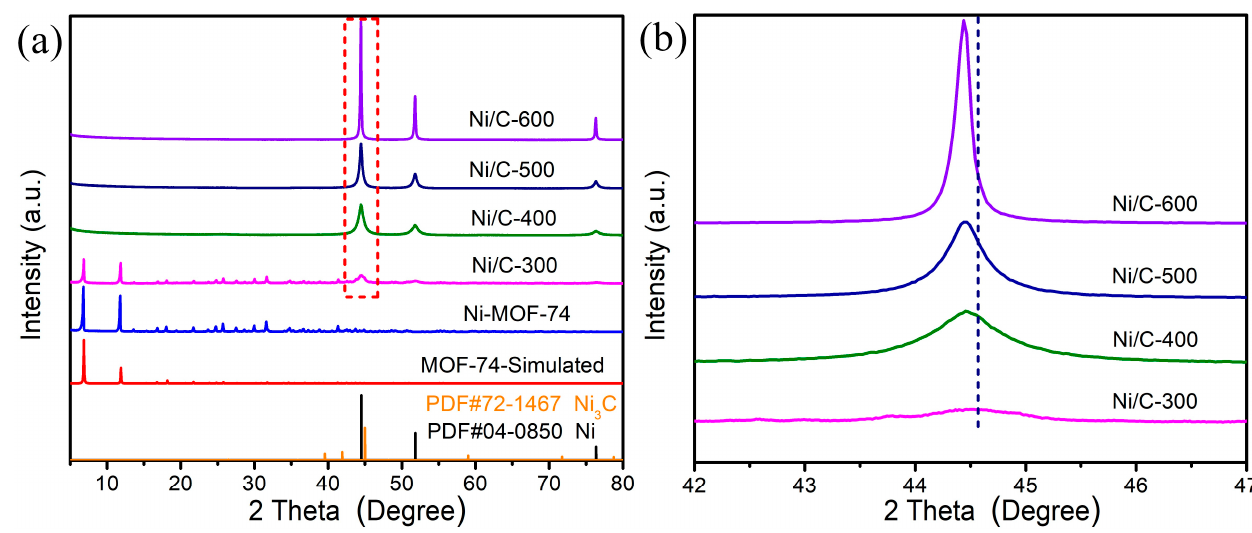
Figure 1. ( a ) Simulated pattern and XRD patterns of MOF-74-Ni and derived Ni/C materials treated at different temperatures, ( b ) enlarged diffraction peak attributed to the Ni (111) crystal plane in ( a ).